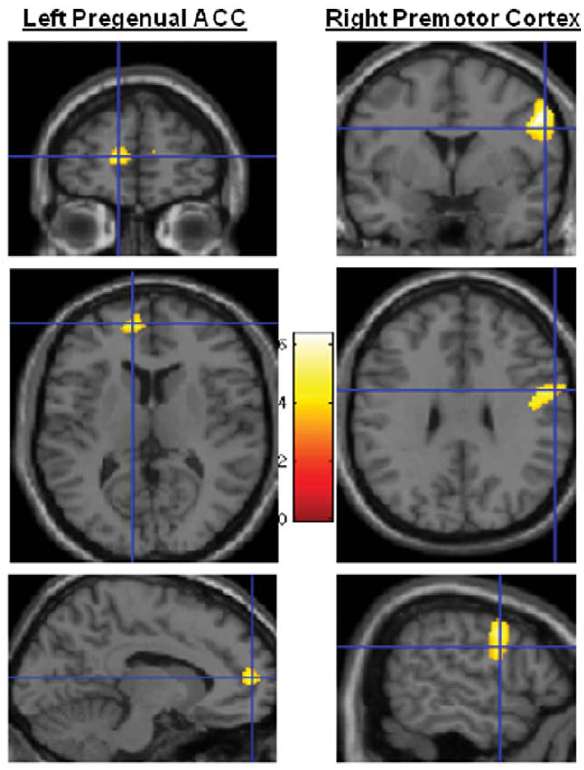
Figure 1. Statistical parametric mapping (SPM) showing clusters in the left pregenual anterior cingulate cortex and the right ventral premotor cortex. There are significant differences in gray matter volume between the PTSD and control groups.